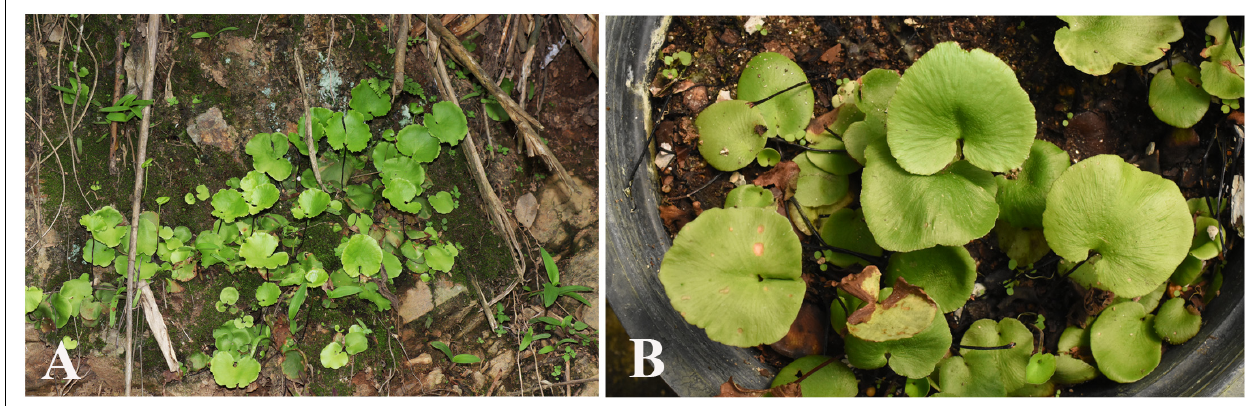
FIGURE 1 | Sporophytes of the introduced model fern organism Asplenium delavayi (A) natural occurrences in Yunnan, (B) cultivated individuals at XTBG. TABLE 1 | Summary of the bacterial community observed in Asplenium delavayi . AccNr